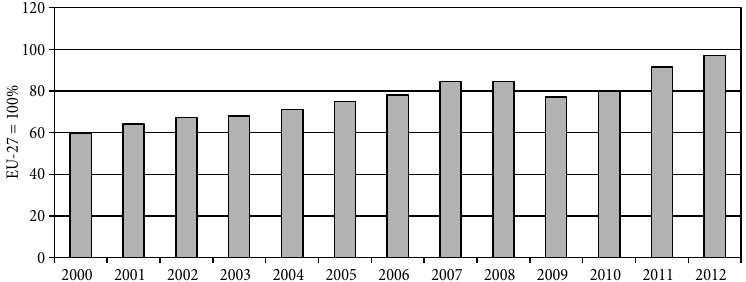
Fig. 3. Lithuanian volume index of CO2 equivalent emissions per capita from total economic activities, compared with the EU-27